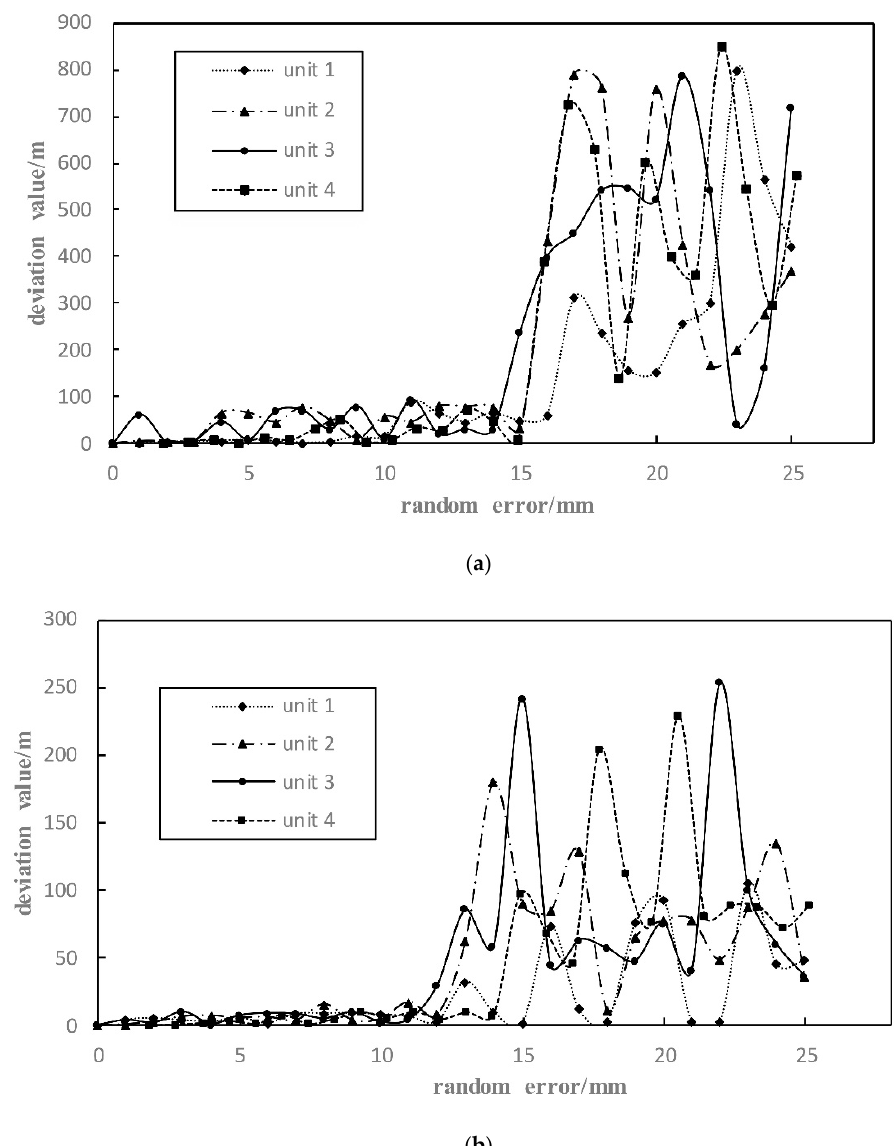
Figure 5. Relationship between random error and the reconstruction result. ( a ) Relationship between the deviation of random error and the curve parameter. ( b ) Relationship between the deviation of random error and the main stake point coordinates.